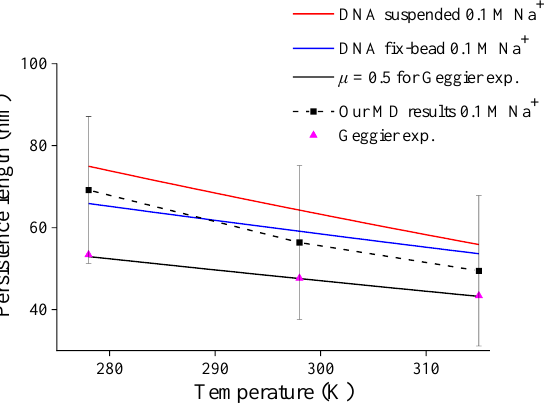
Therefore, with the help of Equations (12) and (13), the critical buckling lengths varying with temperature for DNAs with two end-constraint conditions are shown in Figure 5, obviously the increasing temperature results in a decrease in critical buckling length. Third, by substituting Equations (12) and (13) into Equation (7), one can obtain the variations of the persistence length of DNA with different end-constraints in 0.1 M Na + solution versus temperature, and Figure 6 shows the compassion of these predictions and our MD simulation for DNA suspended in solution. All the present predictions of DNA persistence lengths with different end-constraints decrease approximately linearly with increasing temperature, which reproduces a similar trend in Geggier’s experiment [11]. But different end-constraints cause different decreasing rates; the persistence length for DNA suspended in solution decreases more significantly than that with fix-bead constraint. The decreasing trend and magnitude in our MD simulations are consistent with the prediction for DNA suspended in solution. This further verifies the present model and also sug- gests the necessity of identifying mechanical constraints in DNA experiments by effective length factor.